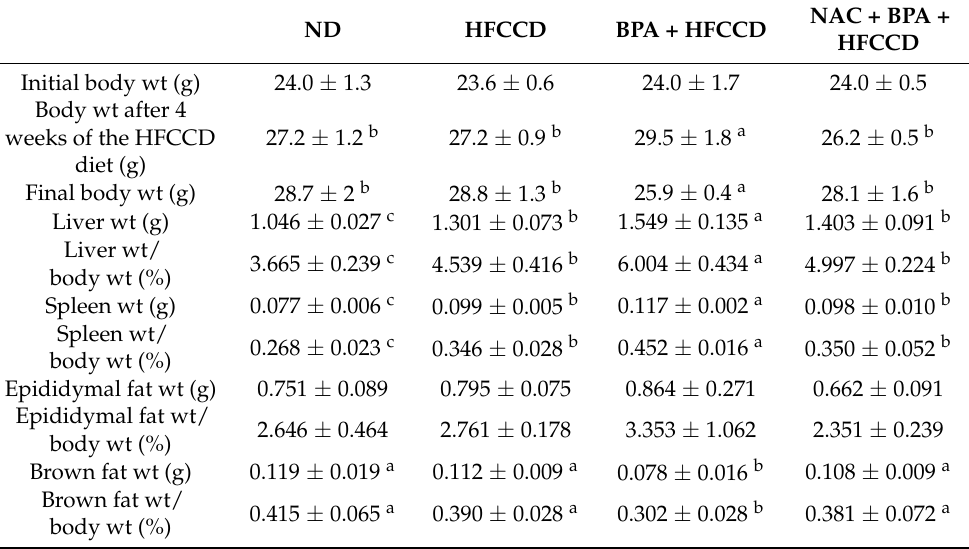
Table 1. Effects of bisphenol A (BPA) on the growth characteristics of mice administered a high- fat/high-cholesterol/high-cholic-acid diet